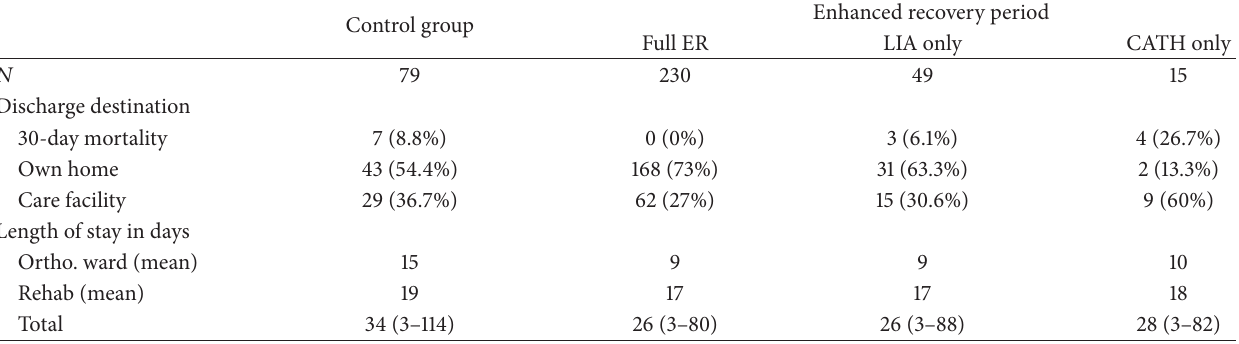
Table 3: Subgroup analysis of management options and patient outcomes. Patients with cognitive impairment are